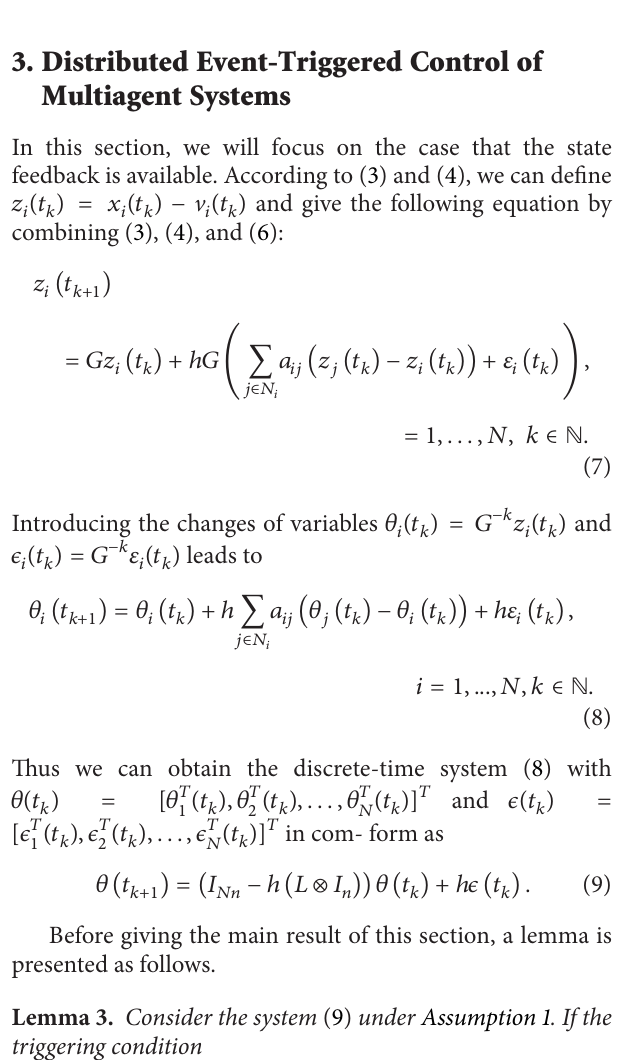
Figure 1: Network